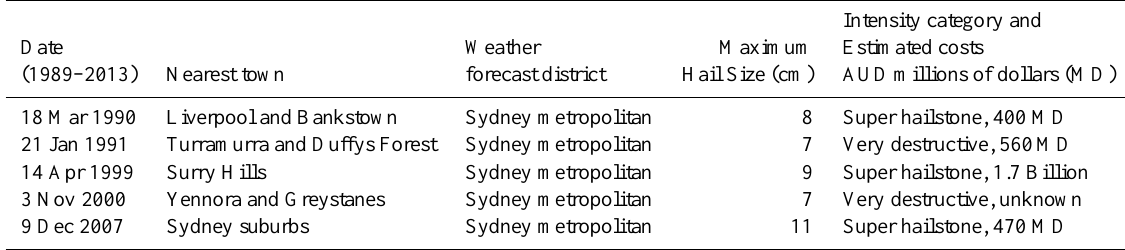
Table 1. Examples of major hailstorms reported in the GMSTWA extracted from the hail GIS database.